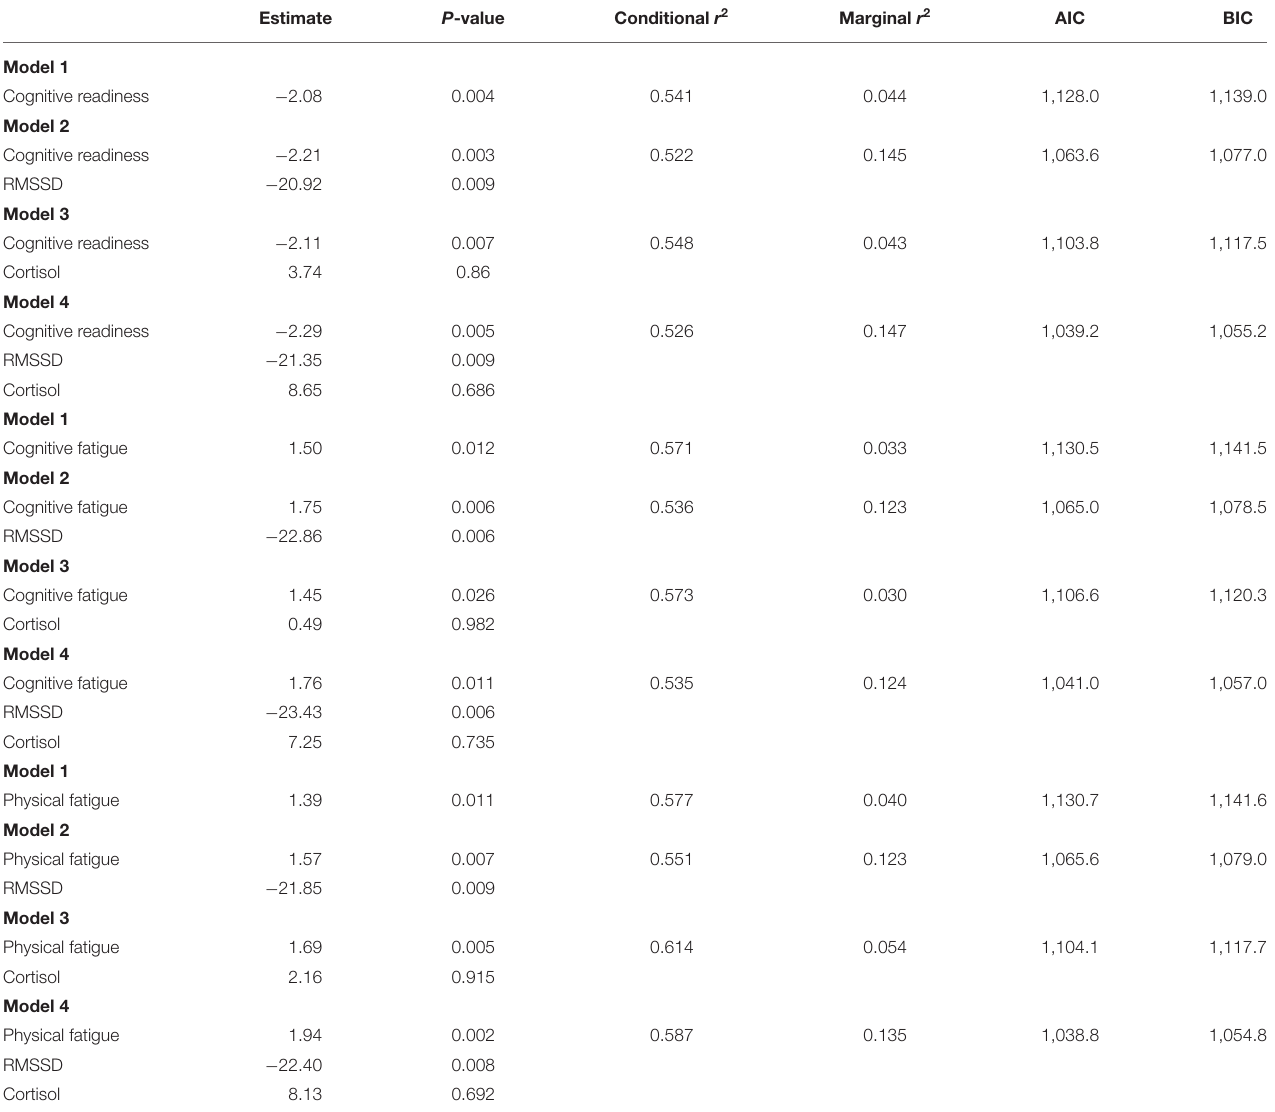
TABLE 3 | Multivariate regression models testing whether the ARMS subscales (Cognitive Readiness, Cognitive Fatigue, Physical Fatigue) predict cognitive performance with and without HRV and